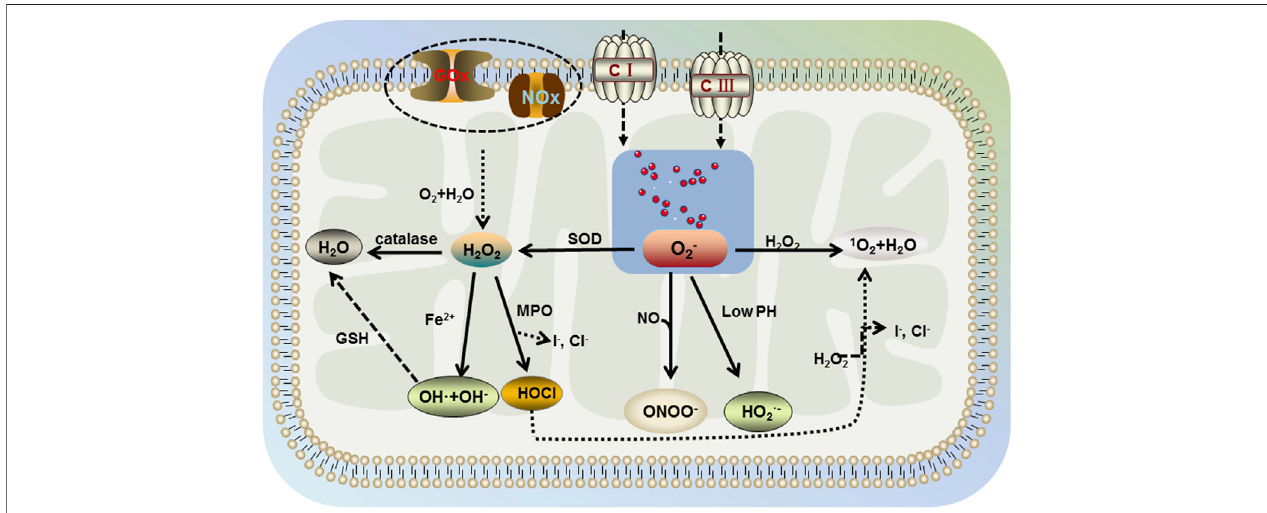
FIGURE2| GenerationofROS.Theaerobicmetabolism ofcellsisaccompaniedbythegenerationofROSincluding nonradicals hypochlorous acid(HOCl),singlet oxygen, hydrogen peroxide (H 2 O 2 ), and free radicals, such as superoxide anion (O 2 − ), superoxide, and hydroxyl radicals. Mitochondria contain large amounts of water and O 2 , which produce H 2 O 2 intracellularly under the action of glucose oxidase (GOx) and NADPH oxidase (NOx). H 2 O 2 further decomposes into water, superoxide, hydroxyl radicals, and hypochlorous acid in the environment involving catalase, Fe 2+ , and myeloperoxidase (MPO). Then, hydroxyl radical generates water under theactionofglutathione(GSH),hypochlorousacidfurthergeneratessingletoxygenandwaterinthepresenceofH 2 O 2 .Freeoxygeninmitochondriawouldbegenerated by superoxide anion under the action of mitochondrial complex I and complex III, which interacts with H 2 O 2 in the body to produce singlet oxygen and water (same as hypochlorite). In addition, superoxide dismutase (SOD) catalyzes the decomposition of superoxide anion into H 2 O 2 , which further generates the benign product water. However, under acidic conditions (lower pH), superoxide anion is protonated and under nitric oxide conditions, peroxynitrite